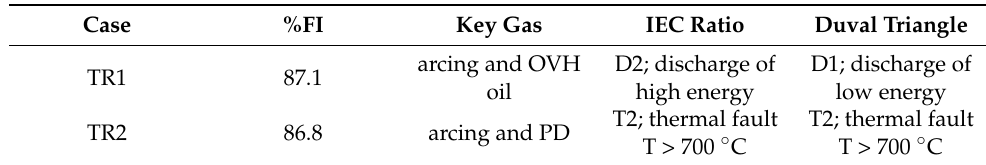
Table 12. Fuzzy logic results of TR1 and TR2.